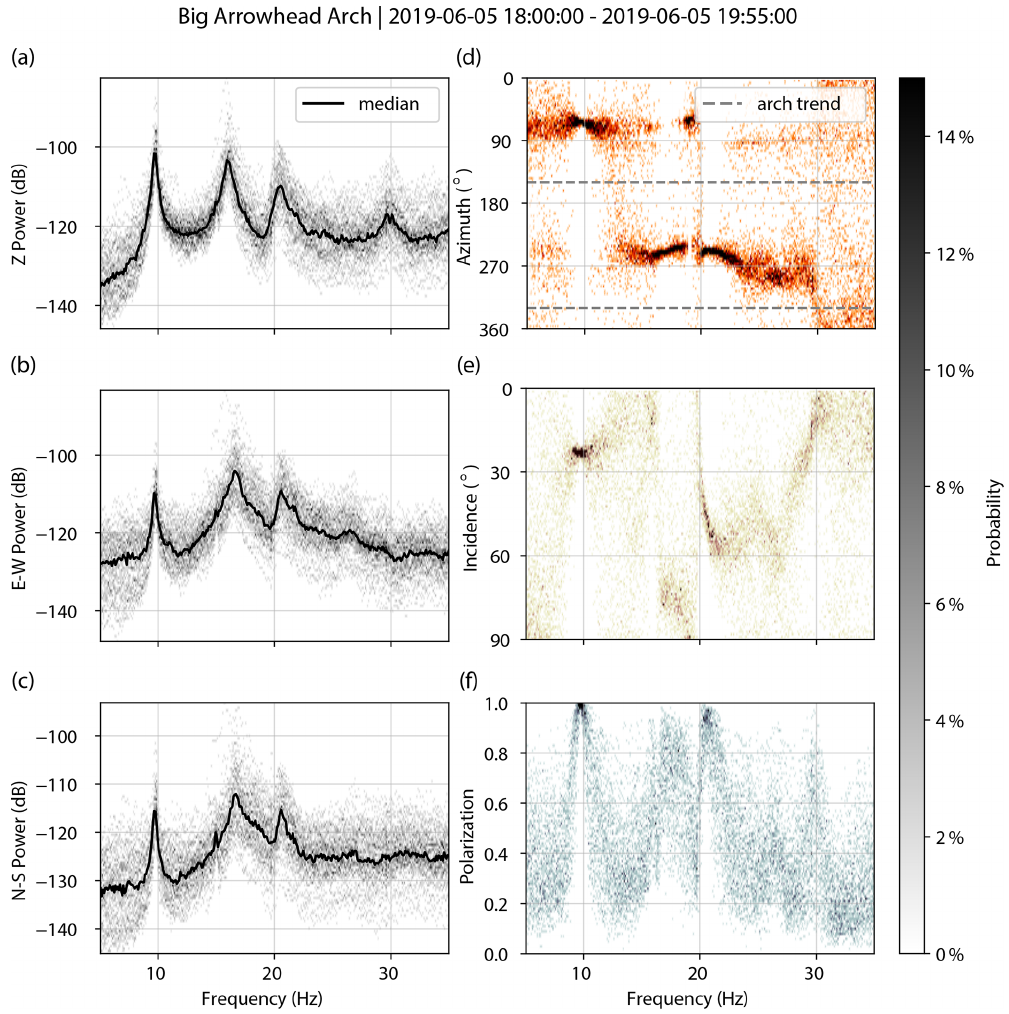
Figure A2. Big Arrowhead Arch. PSDs for vertical (a) , east–west (b) , and north–south (c) components. Decibel powers are relative